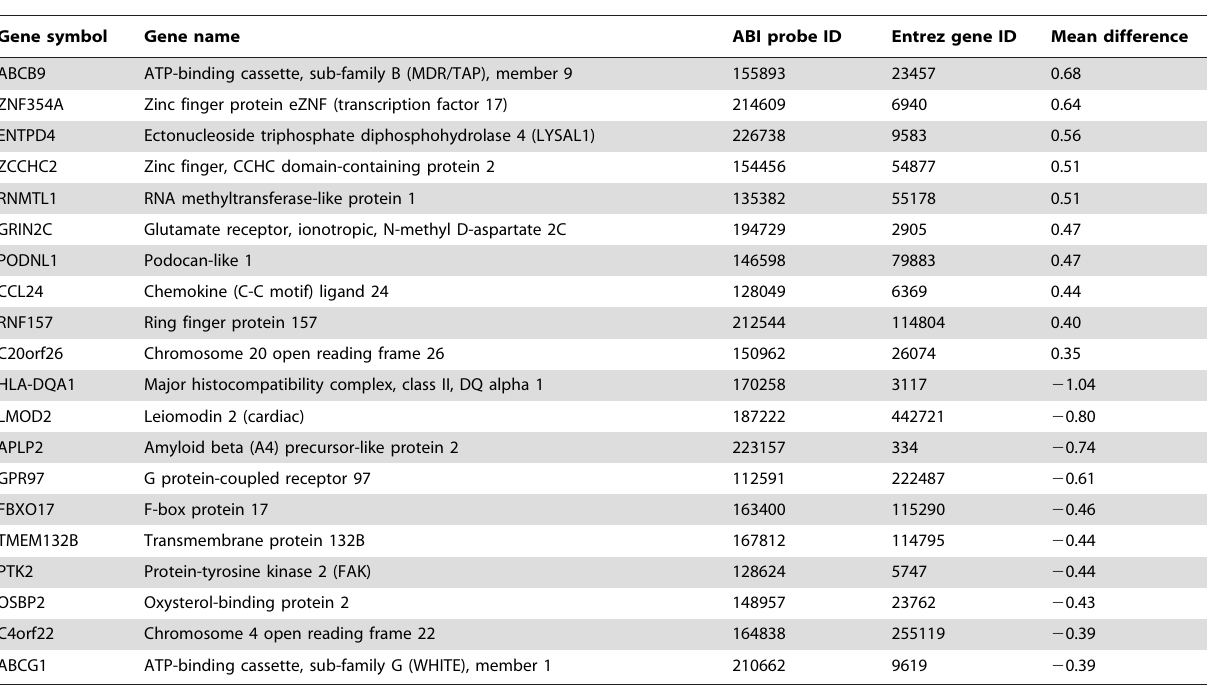
Table 5. Top 10 up- and down-regulated genes associated with AA/EPA ratio (p # 0.01) a .